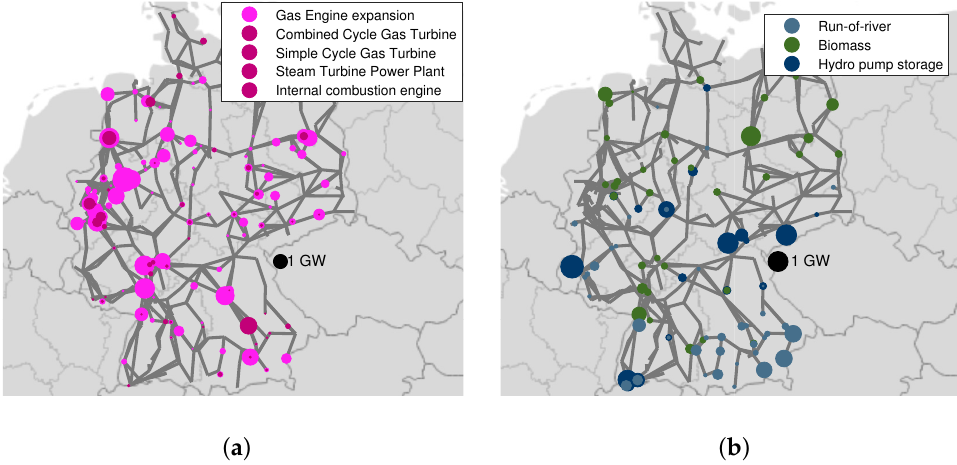
Figure 5. Installed capacities (and expansion potentials) for conventional technologies. ( a ) Gas power plants and expansion potential. ( b ) Other capacities derived from